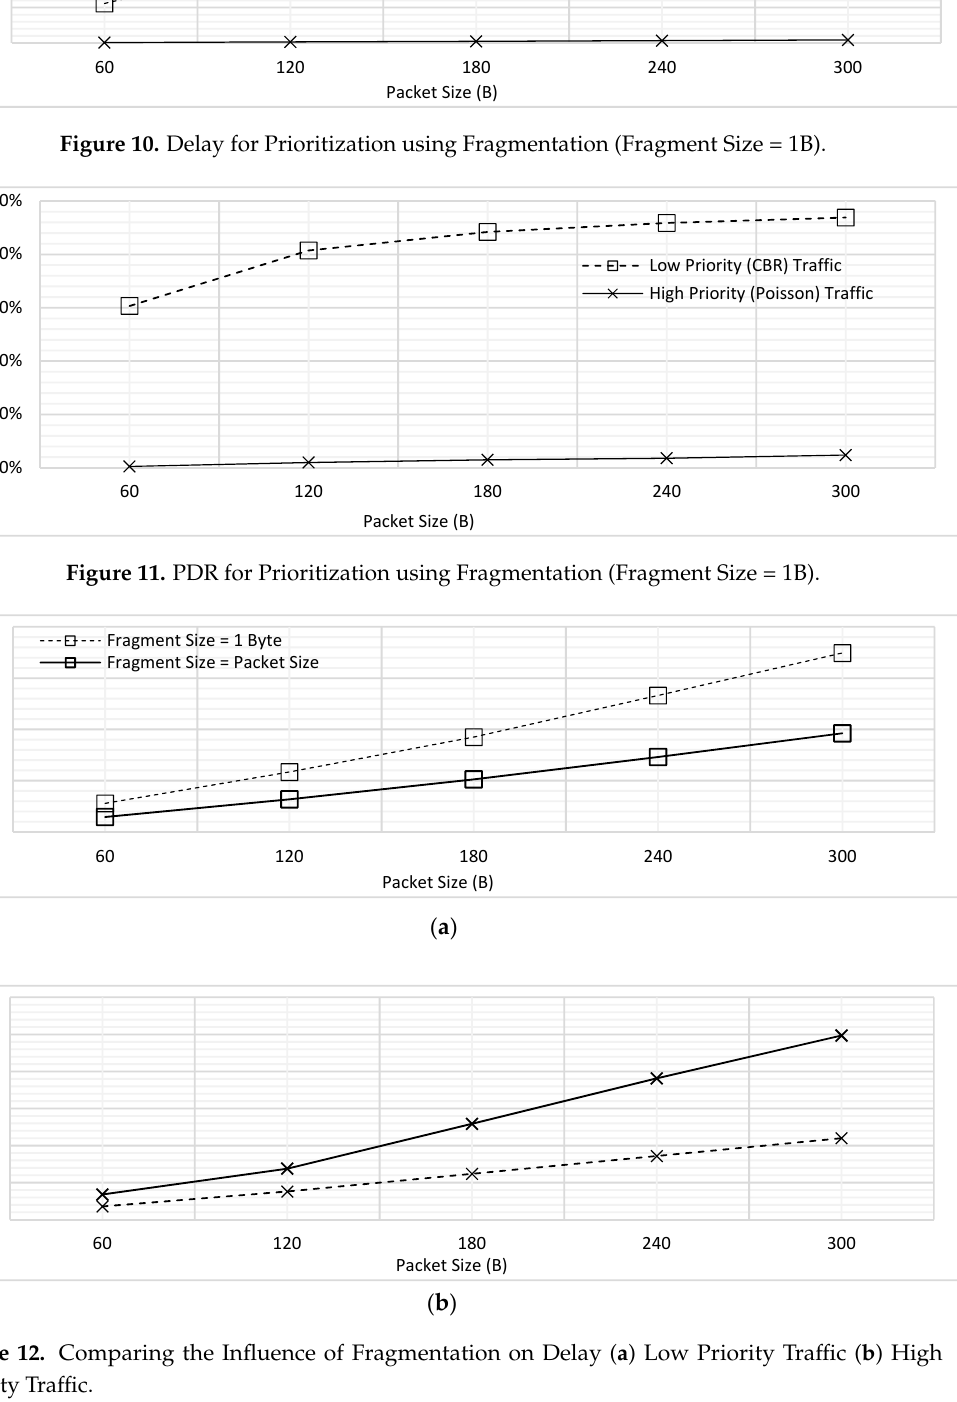
Figure 12. Comparing the Influence of Fragmentation on Delay ( a ) Low Priority Traffic ( b ) High